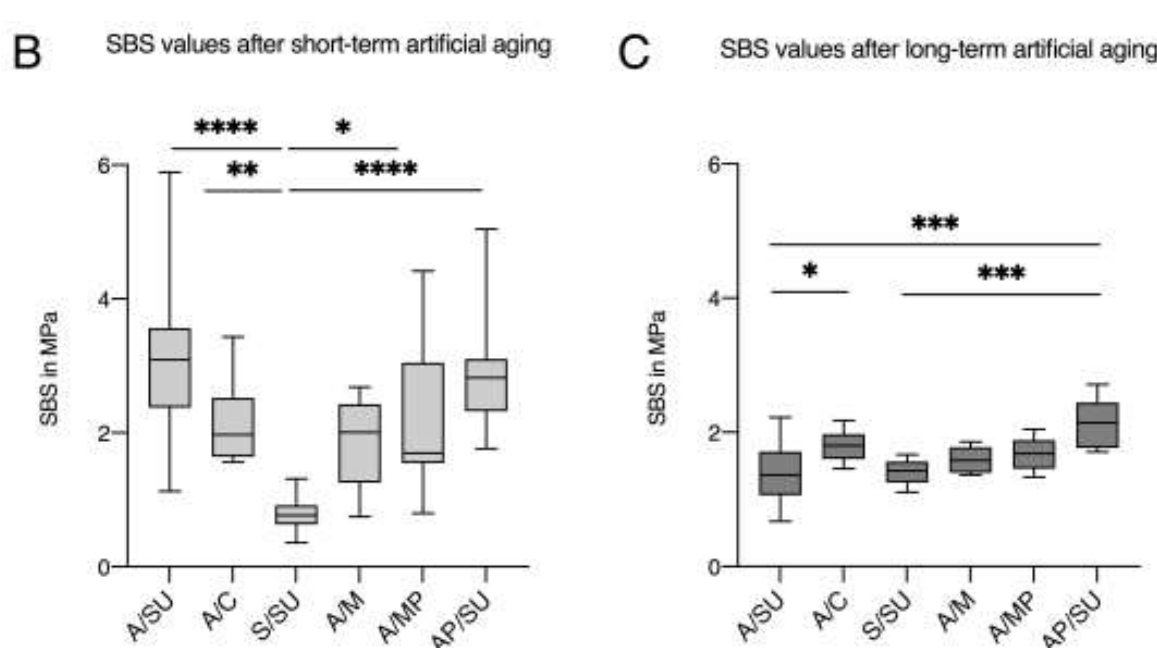
Figure 1. Results of SBS values after short- and long-term artificial aging. A/SU: air abrasion and Scotchbond Universal; A/C: air abrasion and Clearfil Ceramic Primer; A/M: air abrasion and MKZ Primer; A/MP: air abrasion and Monobond Plus; S/SU: silica-coating and Scotchbond Universal; AP/SU: air abrasion, additional cold atmospheric plasma treatment (CAP), and Scotchbond Universal. ( A ) Boxplots comparing SBS values in MPa after short- and long-term artificial aging. ( B ) Median values for short-term test compared by Kruskall–Wallis test * p < 0.05; ** p < 0.005; *** p < 0.0005; **** p < 0.00005. ( C ) Median values for long-term test compared by Kruskall–Wallis test * p < 0.05; *** p < 0.0005. Table 2. Descriptive data analysis for short- and long-term artificial aging. A/SU: air abrasion and Scotchbond Universal; A/C: air abrasion and Clearfil Ceramic Primer; A/M: air abrasion and MKZ Primer; A/MP: air abrasion and Monobond Plus; S/SU: silica-coating and Scotchbond Universal; AP/SU: air abrasion, additional cold atmospheric plasma treatment (CAP), and Scotchbond Universal. Minimum; 25% percentile; median; 75% percentile; maximum; range and number of values are listed in MPa.